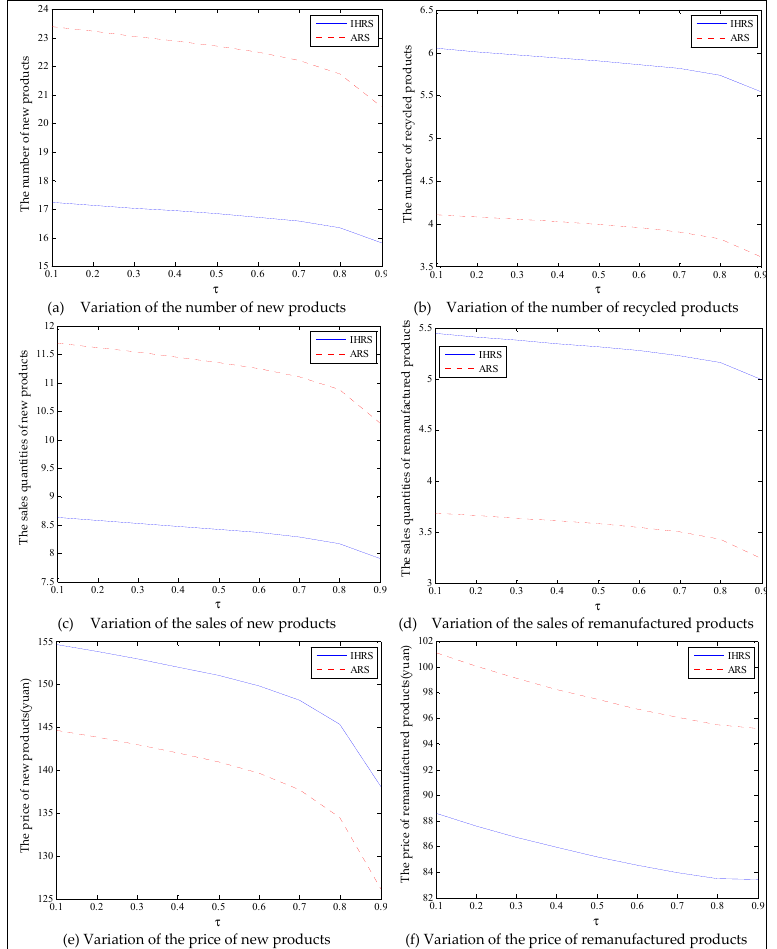
Figure 22. The variation of equilibrium strategies in Case 2 of Section 6.3.